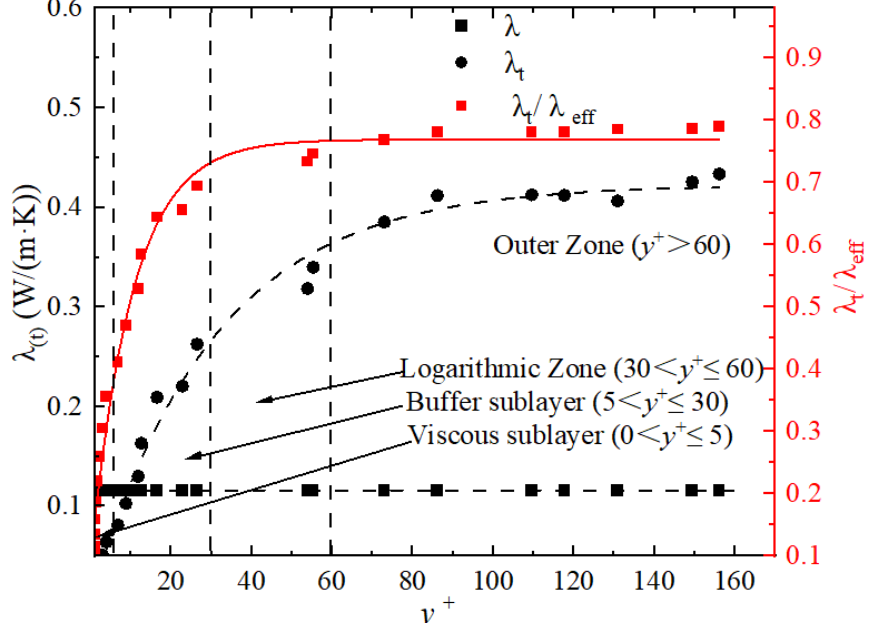
Figure 12. Profiles of contributions of 𝜆 and 𝜆 t to 𝜆 eff , Re in = 2500, and 29% Xe.